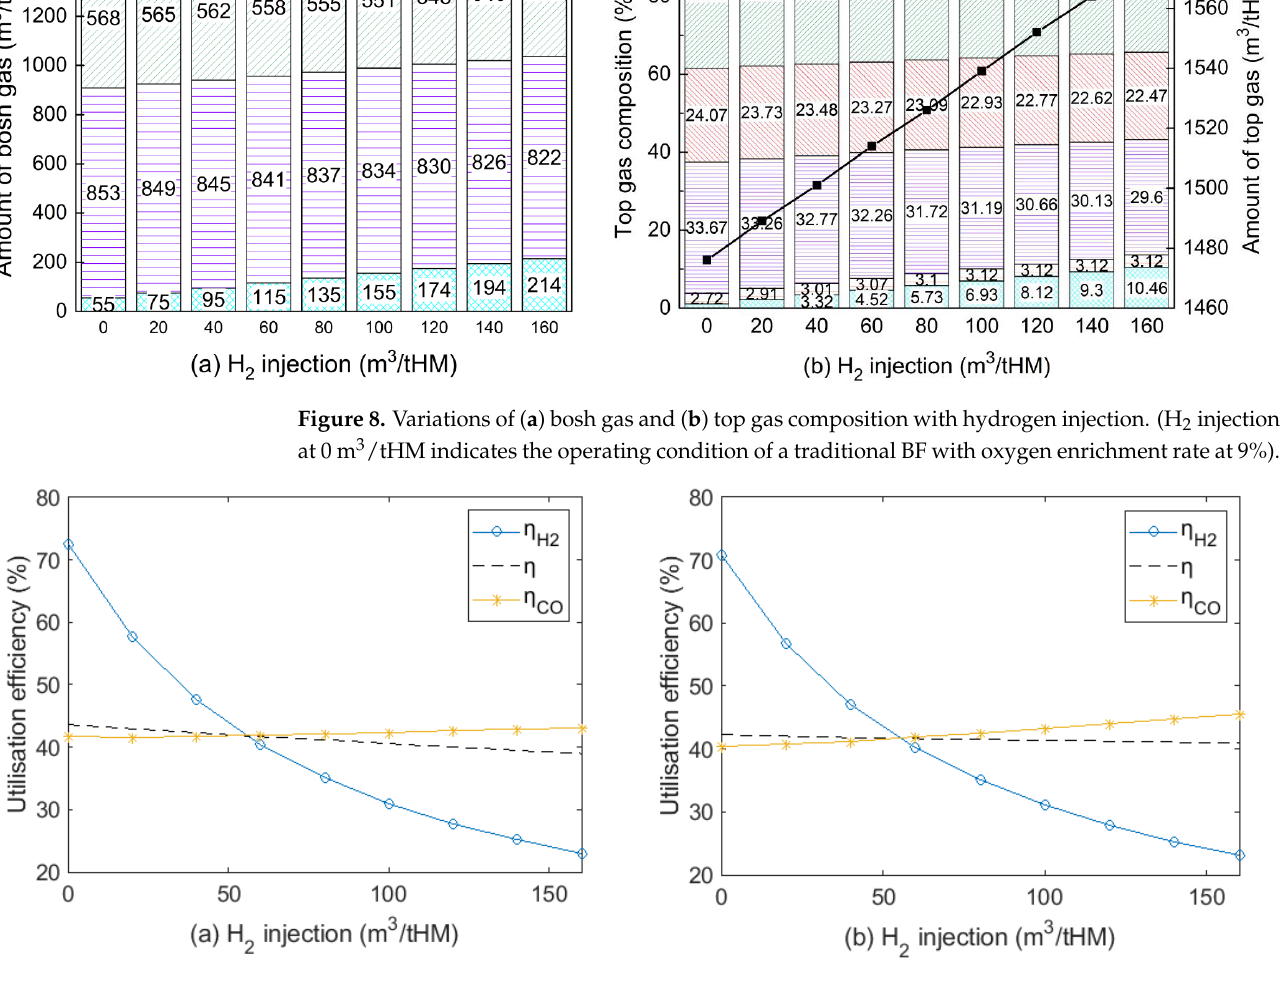
Figure 9. Variations in gas utilisation efficiency with hydrogen injection ( a ) before and ( b ) after thermal compensation.